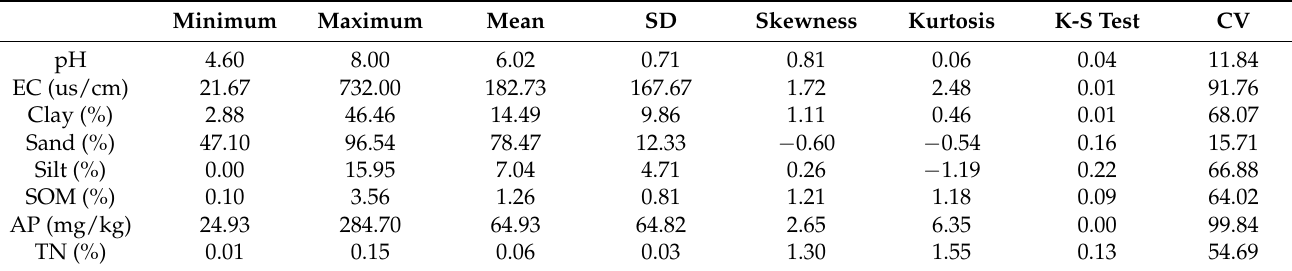
Table 1. Basic statistics of the